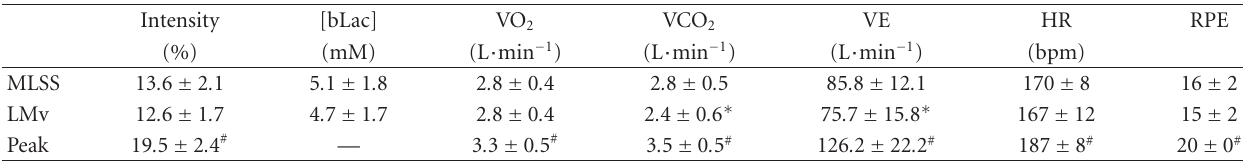
Table 1: Results corresponding to maximal lactate steady-state intensity (MLSS), lactate minimum identified by visual inspection (LMv) and at the peak intensity. Intensity; [bLac] blood lactate concentration; VO 2 : oxygen uptake; VCO 2 : carbon dioxide output; VE: minute ventilation; HR: heart rate; RPE: rate of perceived exertion.